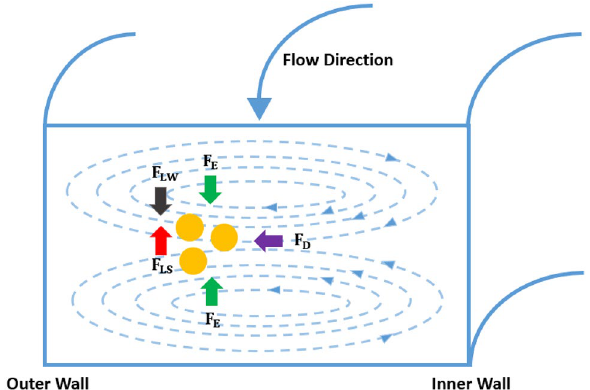
Figure 1. Mechanism of elasto-inertial focusing of particles in the spiral channel. F LW and F LS represent wall- effect-induced lift force and shear-gradient lift force, respectively. These two forces are the components of the nontrivial lateral lift force ( F L ) . F E and F D represent elastic force and Dean drag force, respectively.